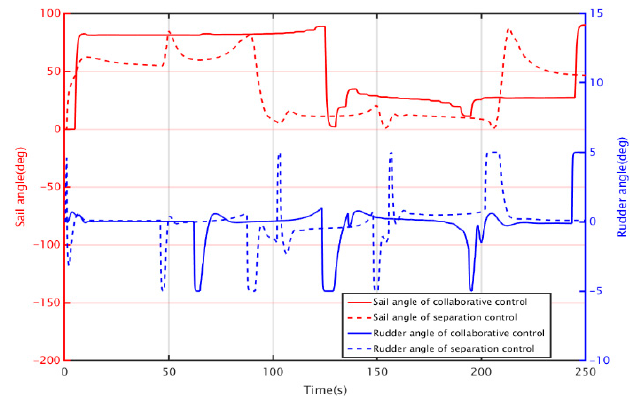
Figure 14. Comparison curves of sail angle and rudder angle of four-point navigation.